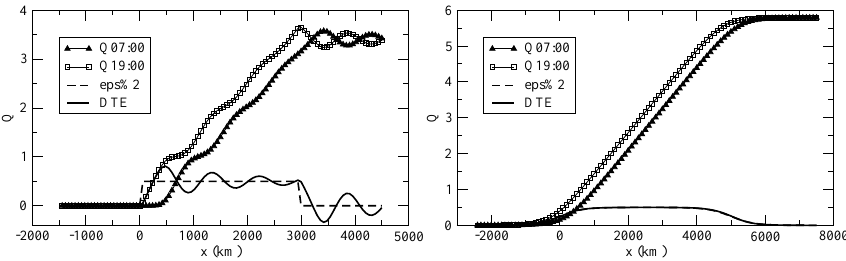
Fig. 15. DTE computation for a fire injecting emissions along x =[ 0 ,L ] in the presence of 1-D advection with a constant wind U =10 m/s for L =3000 km ( L/ ( Uδt ) =3) considering a top-hat source region (left) and L =6000 km ( L/ ( Uδt ) =6) considering smoothed emissions (right). Results are presented for day 29 with concentrations at 07:00 just before fire injection (black triangles) and at 19:00, just after fire injection (white squares). The DTE (difference between the two previous curves, dashed) is compared to half the emission ǫ/ 2 (dashed curve).